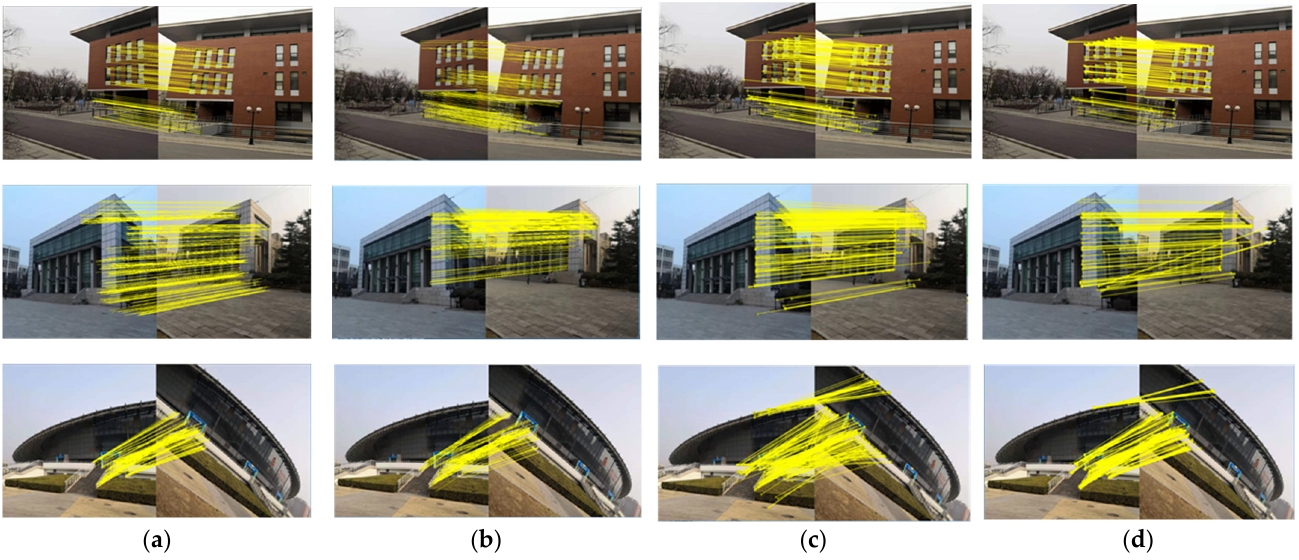
11 of 20 Table 1. The detection results of left and right views before and after gridding. Left View ( c ) Figure 8. Images to be registered: ( a ) images of the scaling group; ( b ) images of the exposure group; ( c ) images of the rotation group. In the proposed method of this article, the number of feature points extracted from